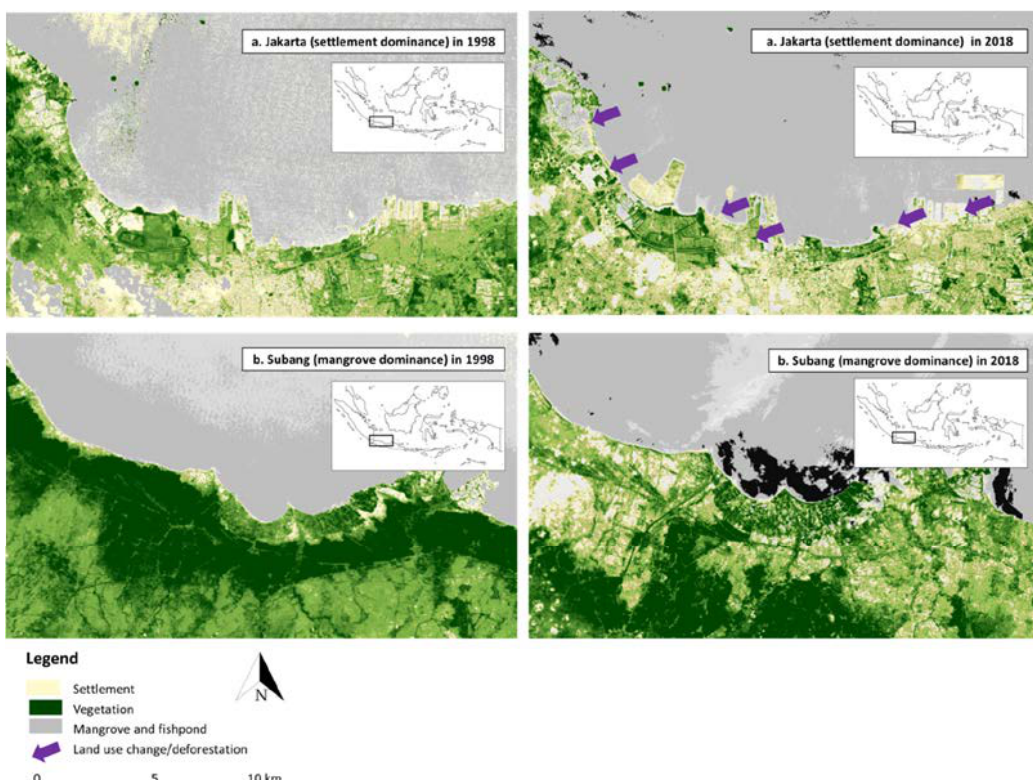
Fig. 2: Land use changes from 1998 to 2018 as indicated by arrows in Jakarta city in the west (settlement dominance) and Subang district in the east (mangrove dominance) on the West Java coast, Indonesia